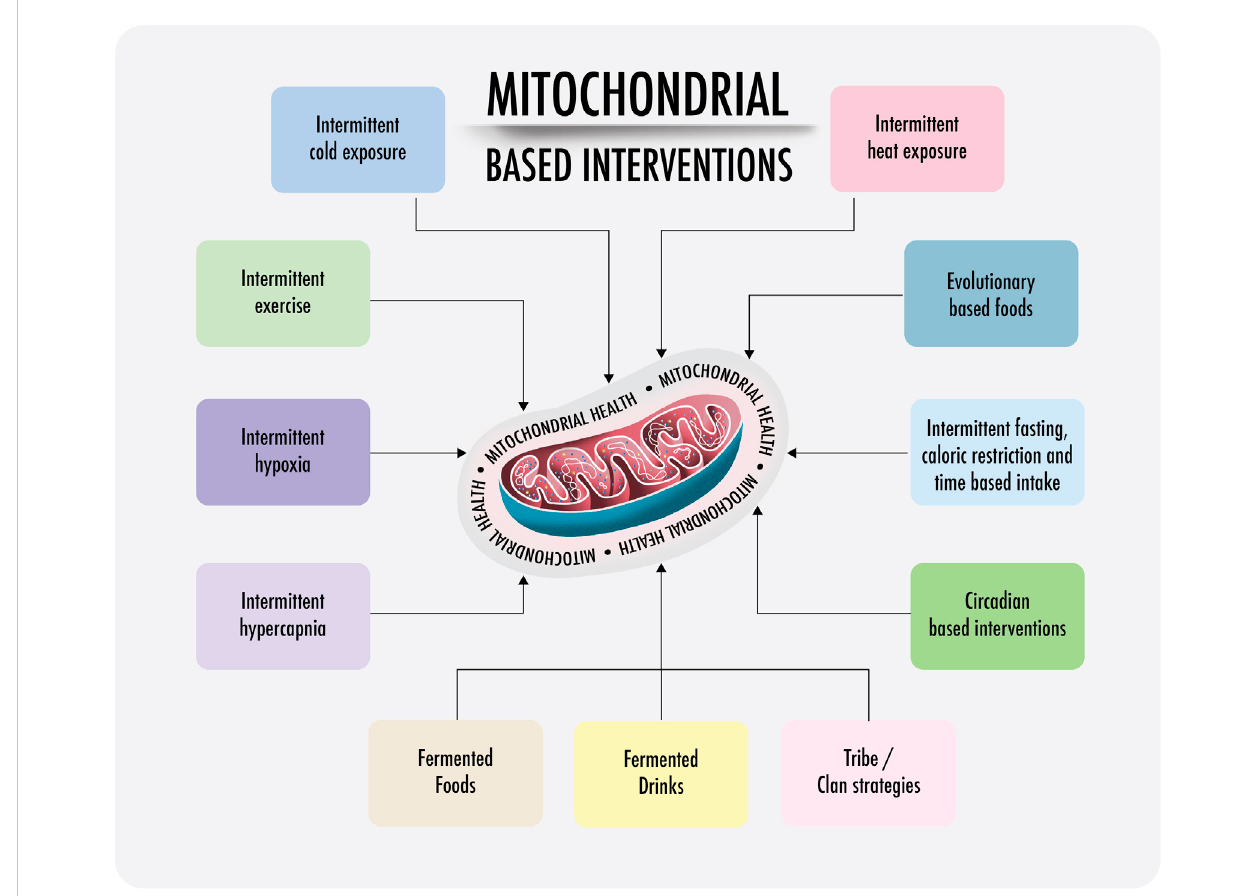
Visual representation of proposed strategiesimproving mitochondrial health: hormesis refers to the evolutionarily conserved adaptive responses of all living organisms to acute/temporary environmental mild physiological stress, nutritional or even voluntary challenges, through which the system modi fi es its tolerance to more dangerous stressors. Lifestyle interventions based on this principle are also known as hormetic strategies. At the mitochondrial level: mitohormetic strategies. Mitohormesis could support mitochondrial resilience and health, especially preventing CNCDs or premature and failed